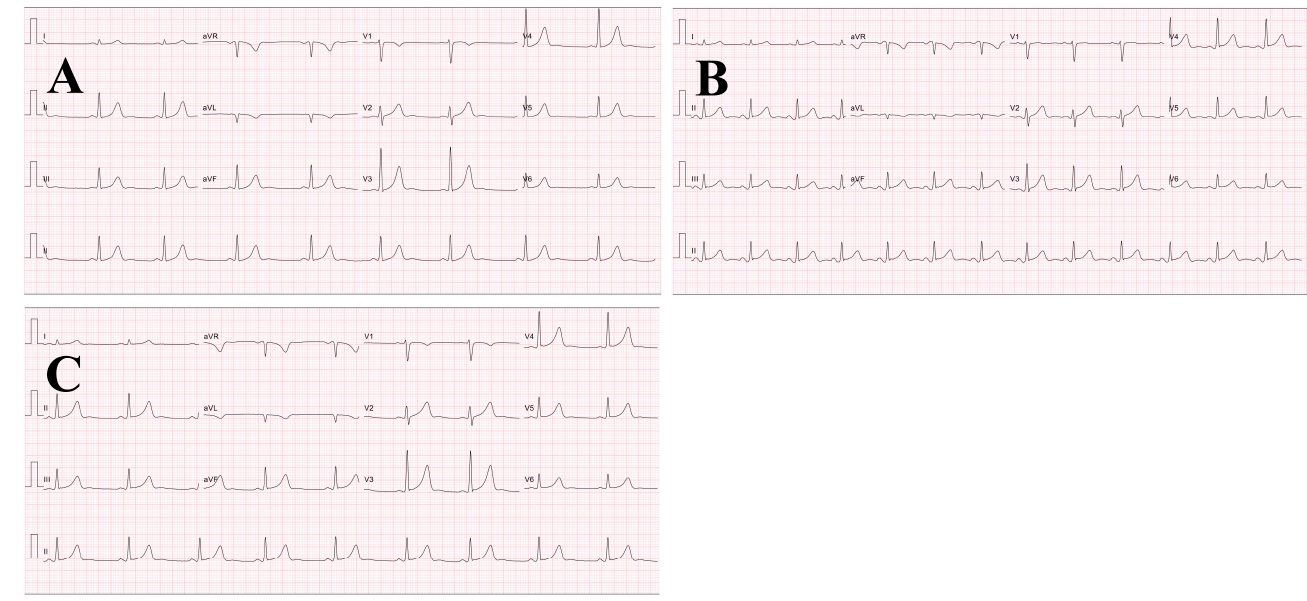
Figure 1. The representative pre- and post-exercise ECG strips (25 mm/s, 10 mm/mV) from a subject. ( A ) pre-exercise; ( B ) 2 h after exercise; ( C ) 4 h after exercise.